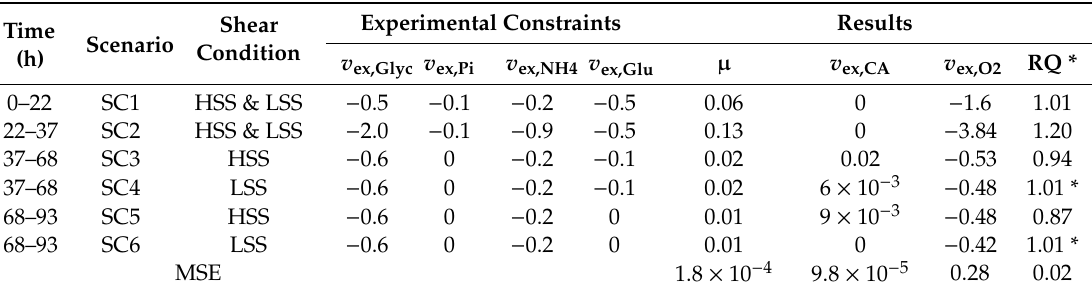
Table 3. Summary of experimental constraints and in silico growth rate, CA secretion and oxygen uptake using the iDG1237